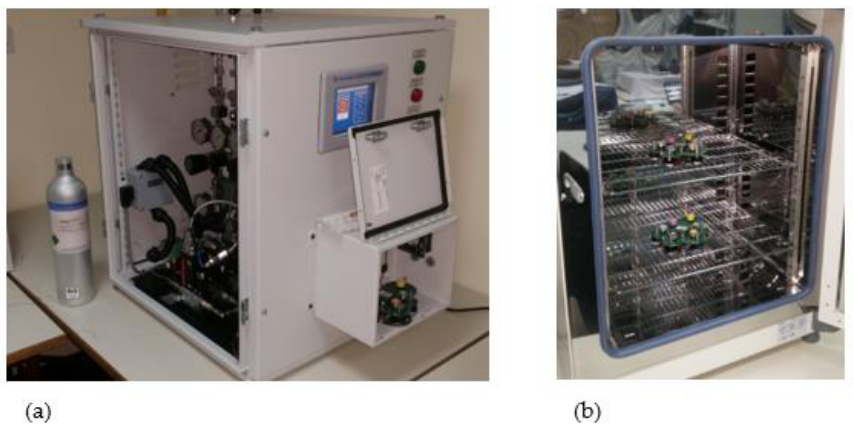
Figure 2. ( a ) Chamber for gas sensor characterization; ( b ) climatic chamber for thermal and RH% test.